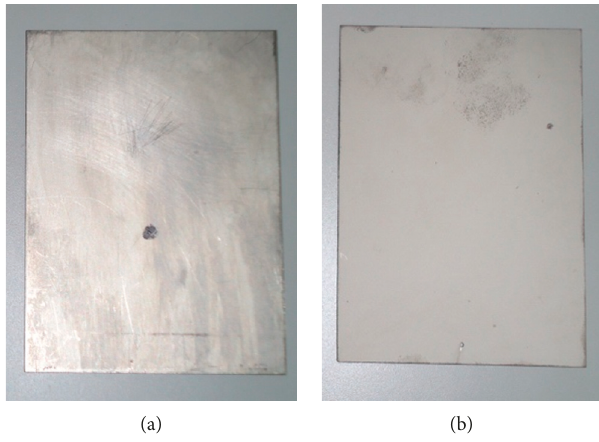
Figure 12: Titanium alloy thin plate and coated plate. (a) Titanium alloy thin plate. (b) Coated plate with NiCrAlY.